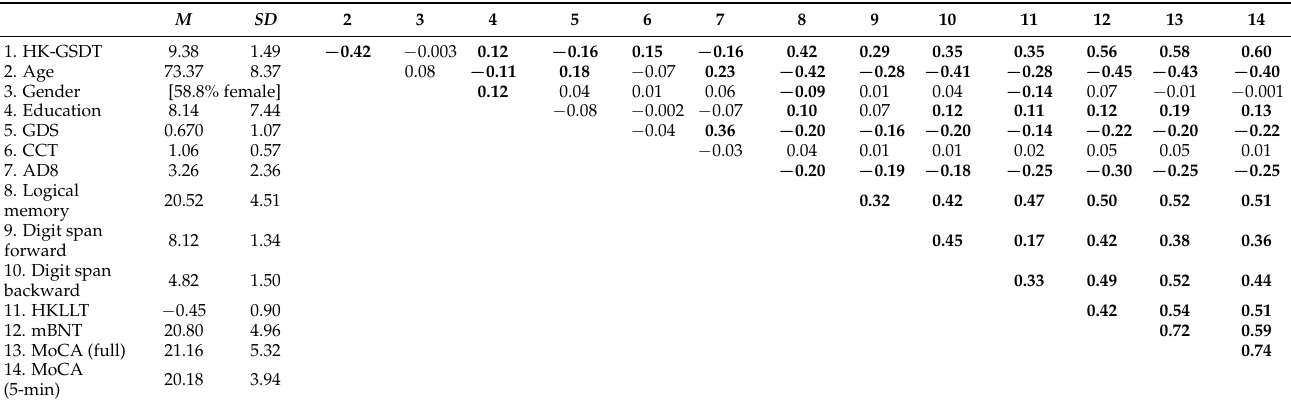
Table 3. Correlations between the HK-GSDT score and other measures ( N =